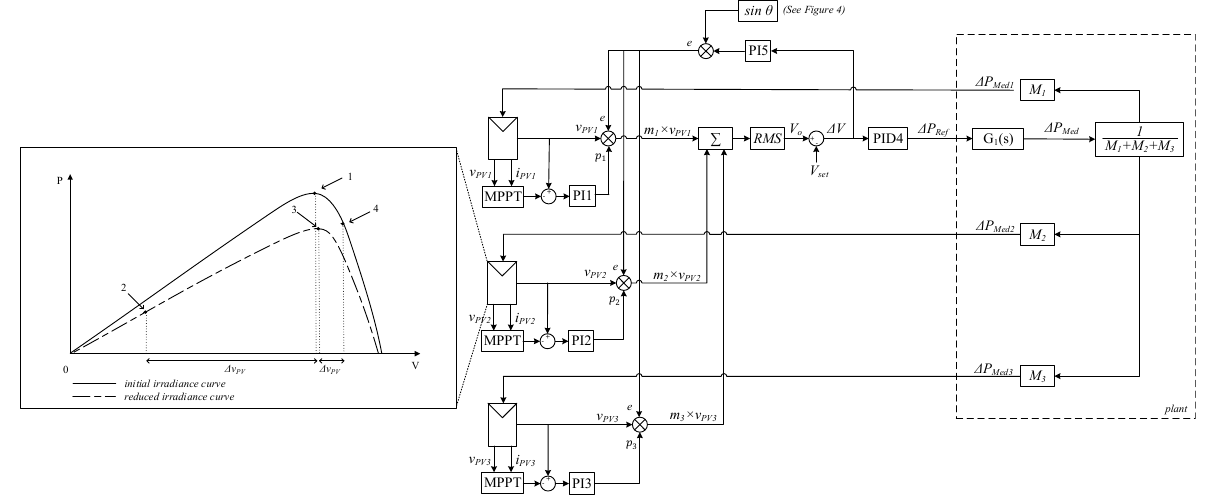
Figure 6. Complete control scheme and hypothetical points of operation upon abrupt irradiance variation.